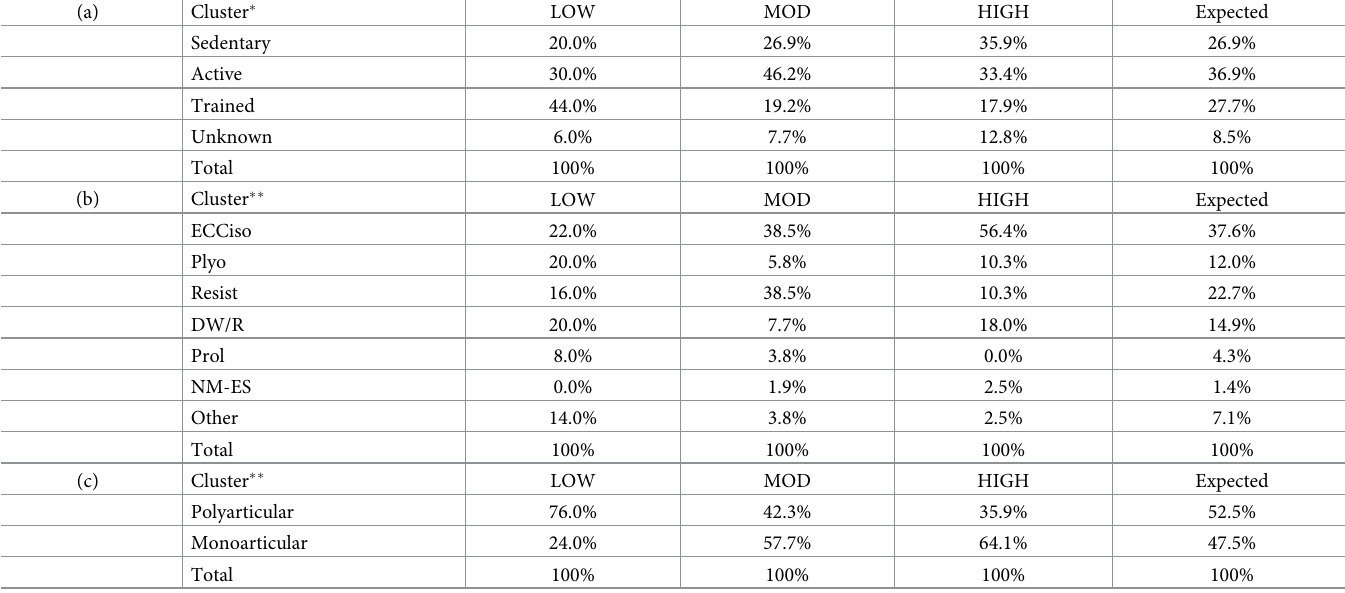
Table 1. LOW, MOD and HIGH clusters’ characteristics. Distribution of training status (a), exercise modality (b) and exercise type (c). Data are expressed in percentage of total participants (%). Expected values corresponds to the distribution of each characteristic in the whole sample. ECCiso: eccentric contractions using an isokinetic ergometer; Plyo: Plyometric exercise; Resist: eccentric/resistance exercises; DW/R: downhill walking/running; Prol: prolonged aerobic exercise; NM-ES: Neuromuscular electrostimulation. Any significant association between clusters and characteristics are displayed ( � : p < 0.05; �� : p < 0.01).